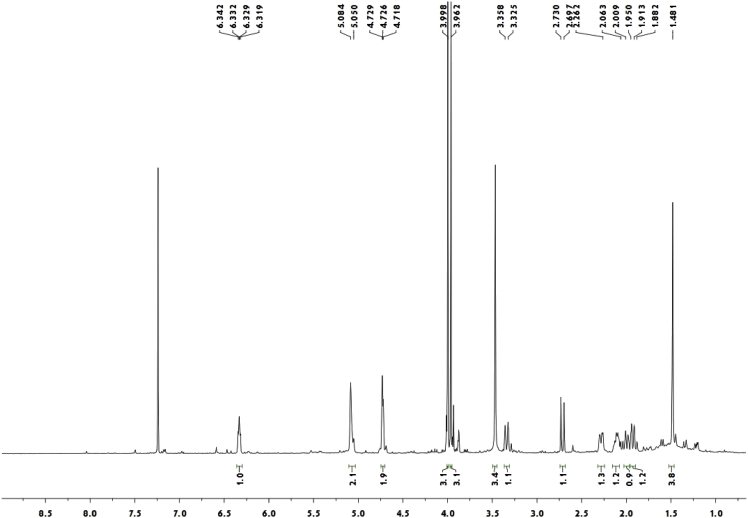
1H-NMR spectrum of meroterpenoid 5.